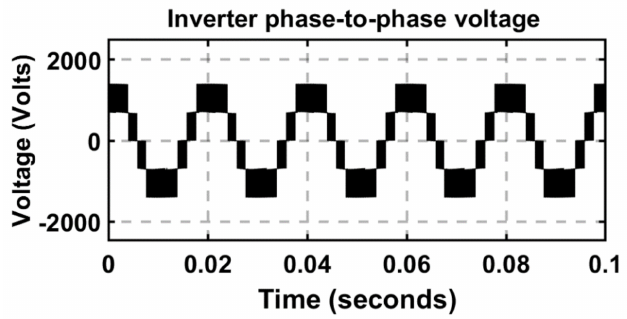
Figure 7. Inverter phase-to-phase